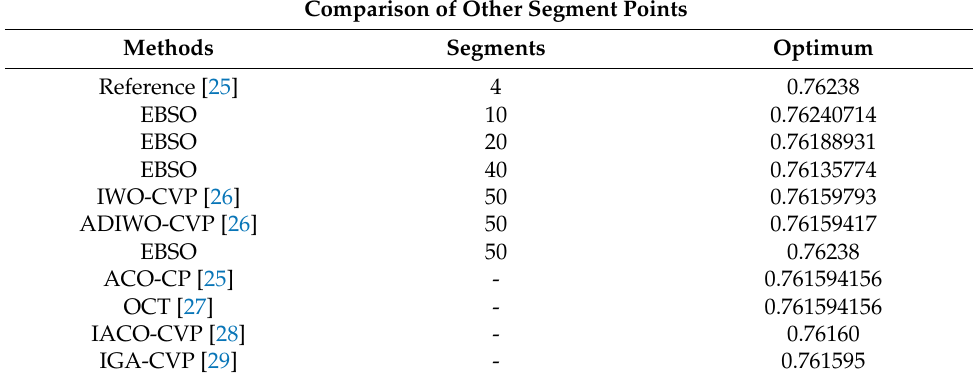
Table 4. Comparison of methods of Case 1.